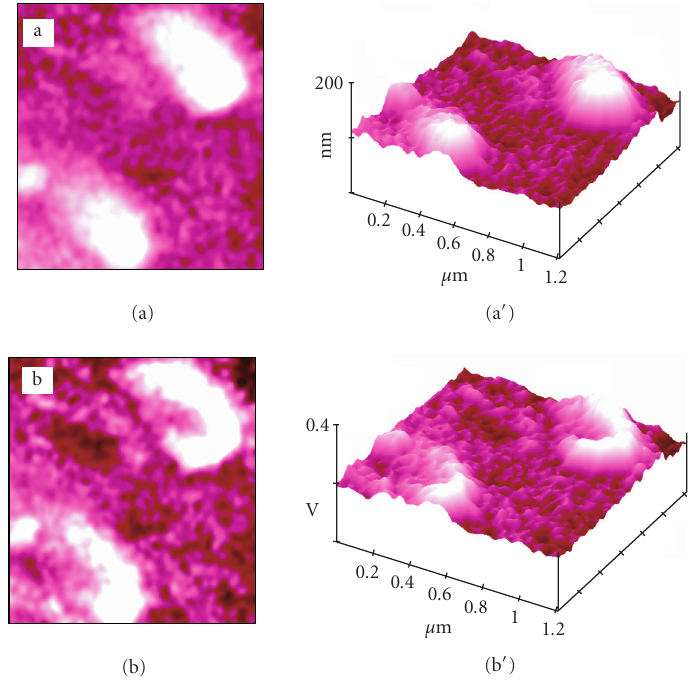
Figure 47: Simultaneous apertureless shear-force AFM (a), (a (cid:3) ) and fluorescence SNOM (b), (b (cid:3) ) of dye nanoparticles in polyvidone resin showing angular aggregation by the di ff erence in shape of topographic and optical image both in the top views (a), (b) and in the surface views (a (cid:3) ), (b (cid:3)